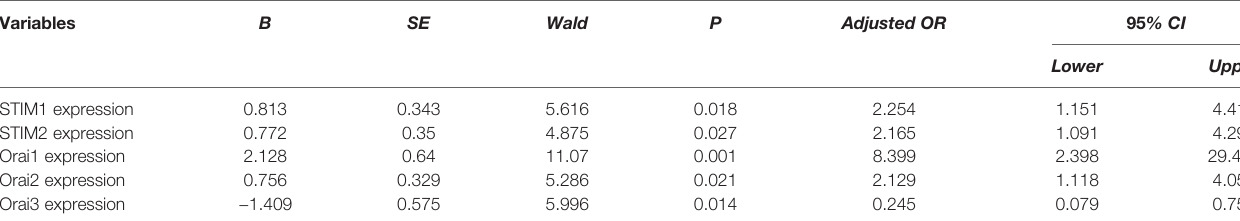
TABLE 3 | Logistic regression analysis of gene expression after adjusting for age and BMI. Variables